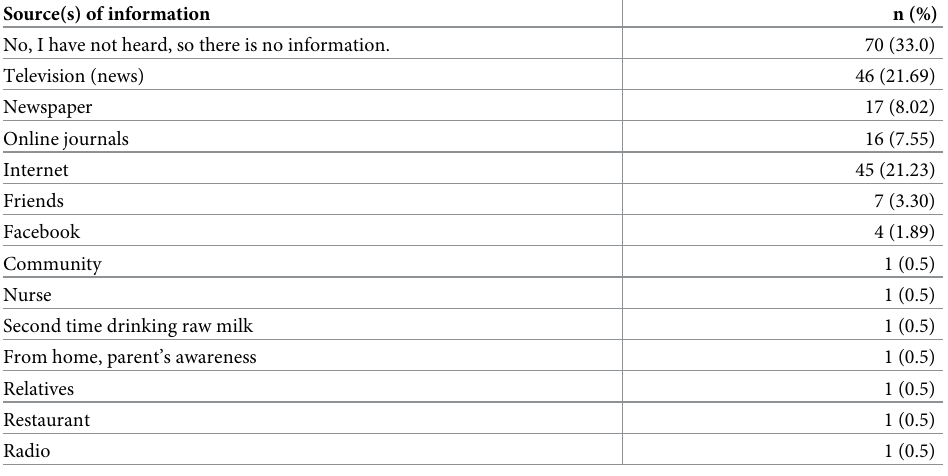
Table 3. Distribution of the respondents (%) according to what was the source of information on the food poison- ing outbreak (N = 212). Source(s) of information n (%) No, I have not heard, so there is no information.